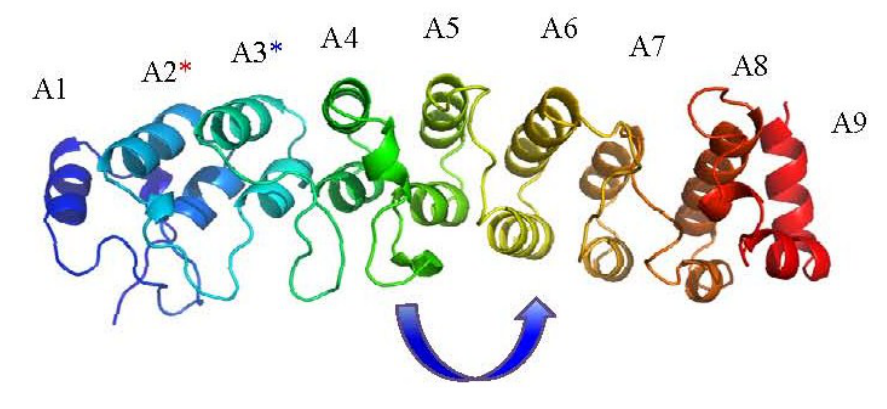
Figure 2. The vaccinia virus K1L ankyrin protein structure (PDB ID: 3KEA) [58]. ANK repeats are numbered A1-A9; the terminal ANK repeat motifs 1 and 9 are in-complete motifs in the structure. The blue asterisk refers to residues F82 and S83 on A3 [59] required for in vitro viral replication; the red asterisk refers to residues C47 and N51 on the A2 repeat that are spatially contiguous with F82 and S83 and are also required for host-range function. The arrow indicates a surprising 90° shift in the orientation of β-turn loop arrangement from repeats A4 to